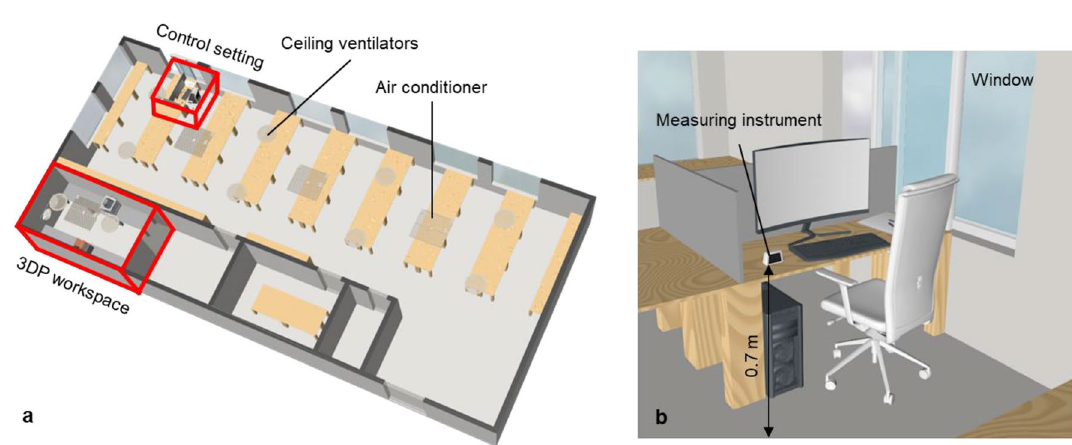
Figure 3. The office is the control setting. ( a ) The layout of the control setting and ( b ) the location of